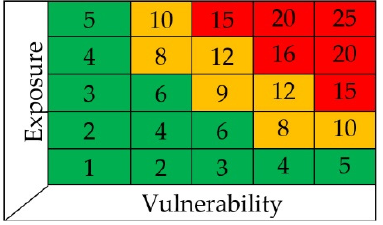
Figure 3. Safety risk acceptance matrix. Level 1 to 5 acceptable; 6 to 12 tolerable, but requires risk mitigation; 13 to 25 not acceptable.